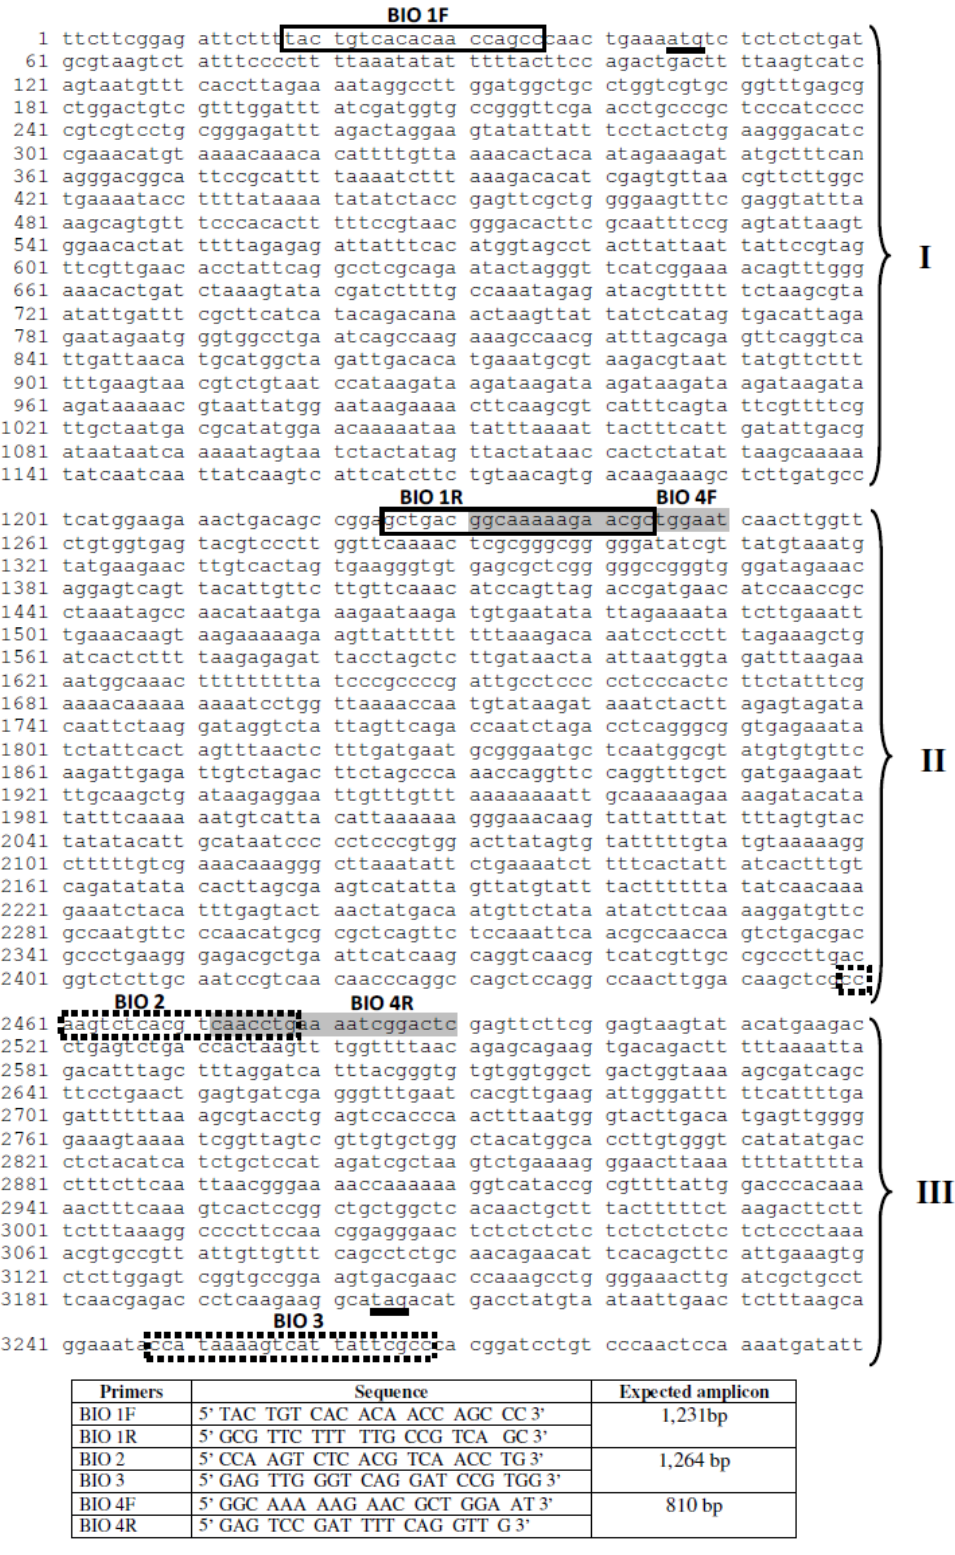
Figure 6. Annealing position of the primers related to the myoglobin gene from B. glabrata (U89283.1). Solid line: Primers BIO 1F/R. Dashed line: BIO 4F/R. Grey box: BIO2/3. Tick line: Initiation and stop codon. I, II and III: introns 1, 2 and 3